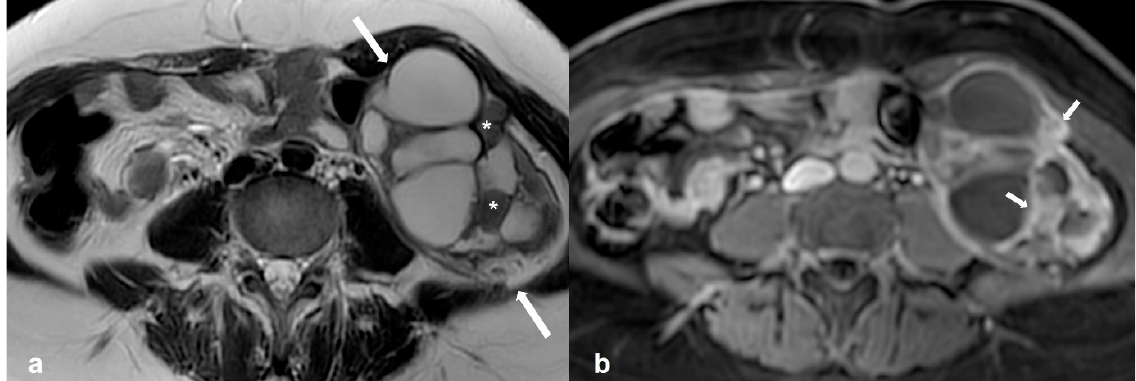
Figure 4. Low grade serous cystadenocarcinoma. Axial T2 weighted image ( a ) shows a multilocu- lated, predominantly cystic mass at the left ovary (white arrows) with solid tissue (asterisks) show- ing avid enhancement on the T1 weighted FS CE image (( b ), white arrows).